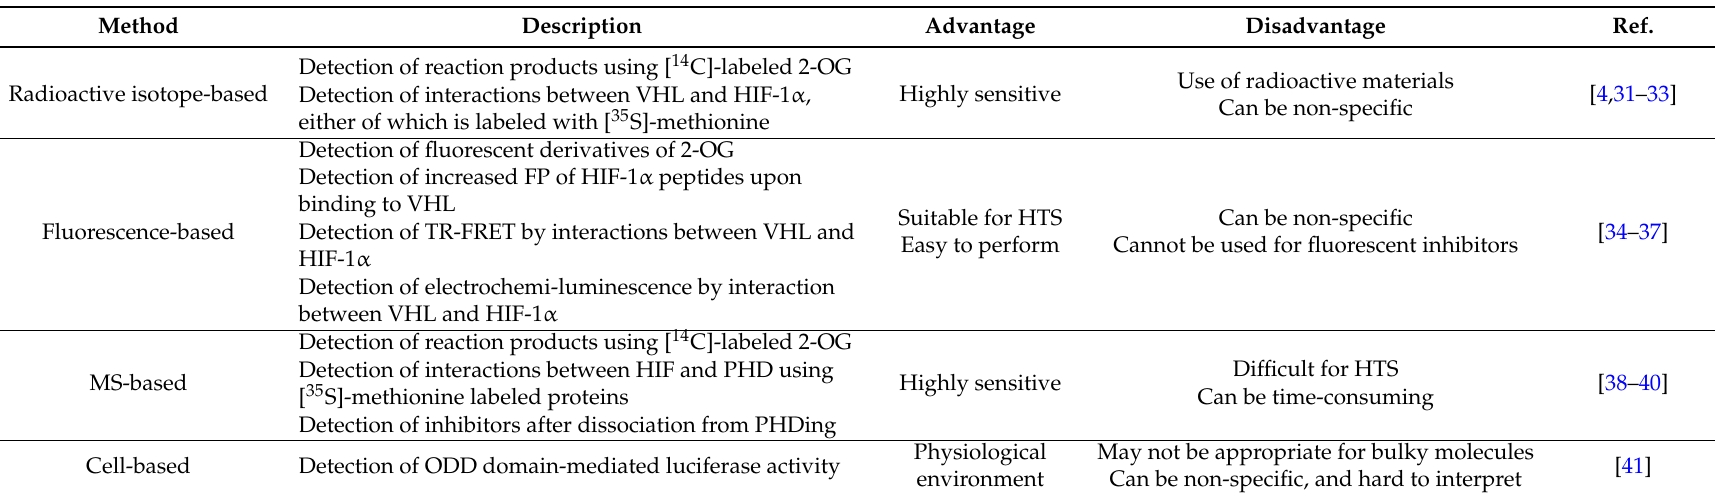
Table 1. Summary of PHD activity